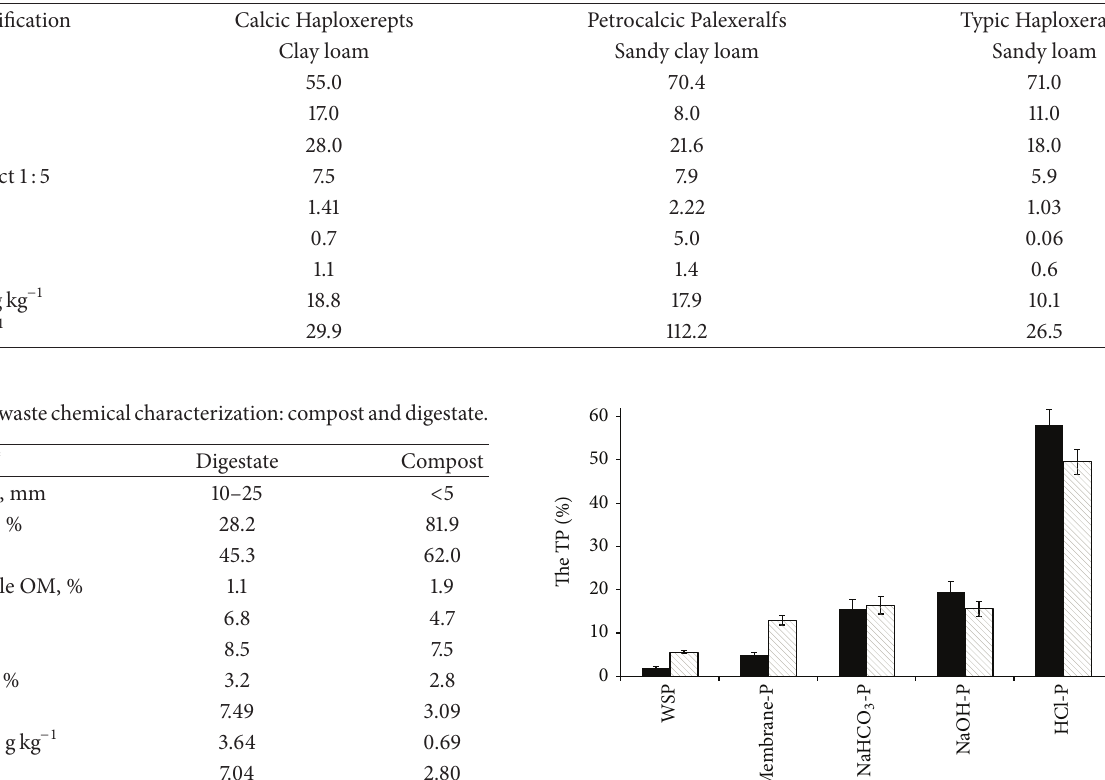
Table 1: Chemical characteristics of the soils used in this study.